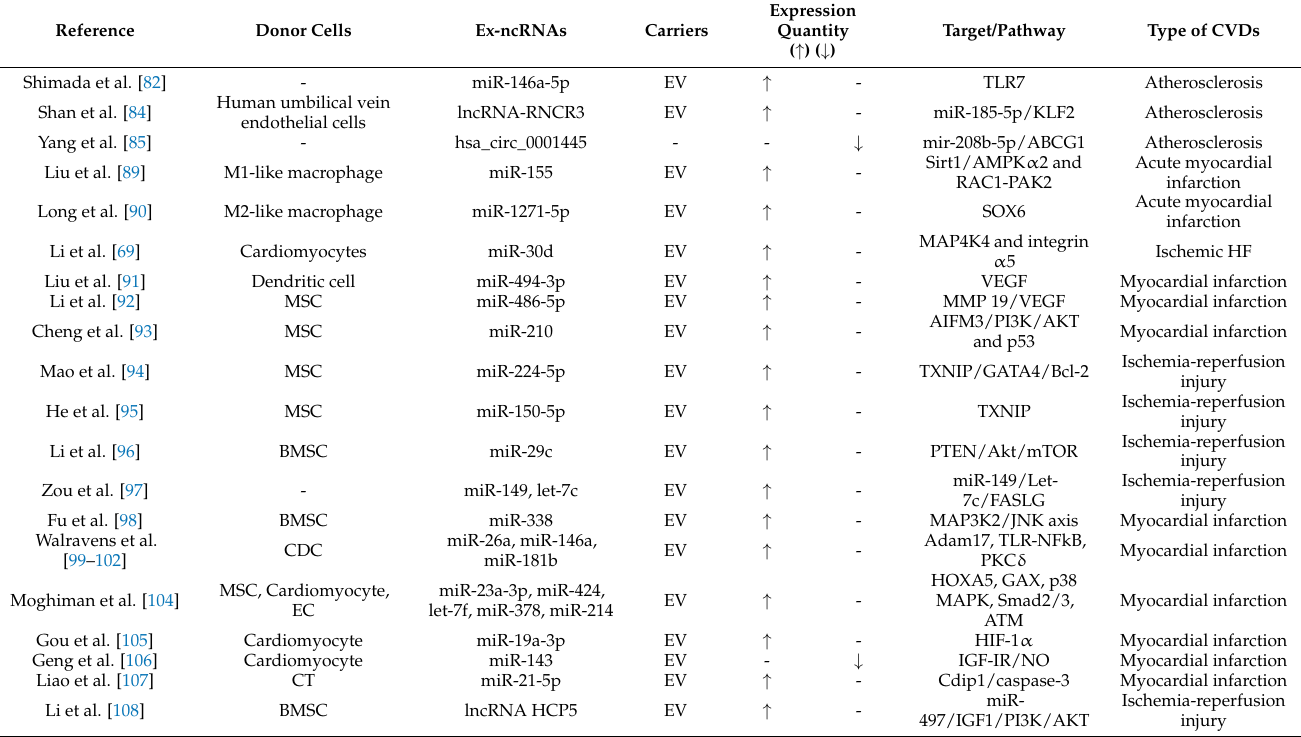
Table 2. Ex-ncRNAs as therapeutic targets in